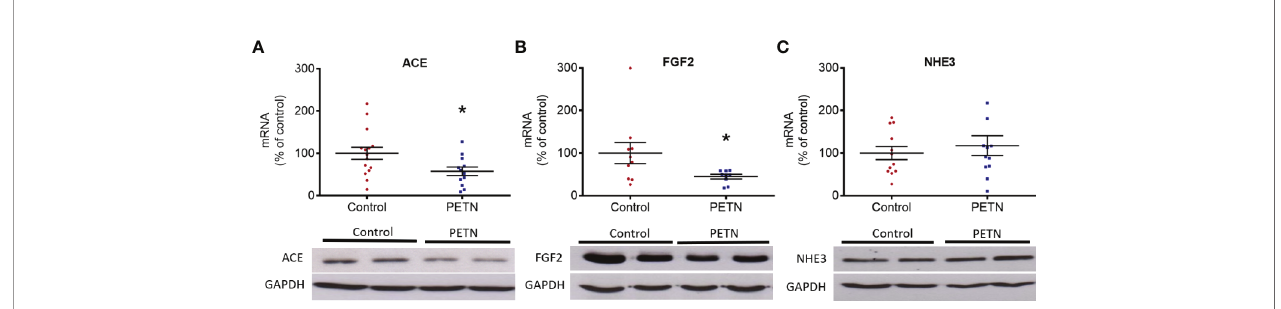
FIGURE 2 | Maternal pentaerythritol tetranitrate (PETN) treatment leads to differential gene expression in the kidney of female offspring. Parental spontaneously hypertensive rats (SHR) were treated with or without PETN (50 mg/kg/day) during pregnancy and lactation periods. The gene and protein expression of angiotensin- converting enzyme (ACE) (A) , basic fi broblast growth factor (FGF2) (B) , and sodium-hydrogen antiporter 3 (NHE3) (C) were studied with quantitative real-time PCR and Western blotting using kidney of 16-week-old offspring, respectively. RNA polymerase II was used as reference gene for quantitative PCR (qPCR) and GAPDH was used as internal control for the protein loading in Western blotting. Column represents mean ± SEM, n=8 – 12. Student ’ s t test was used for comparison of PETN group with control group. * P < 0.05, vs. control group.